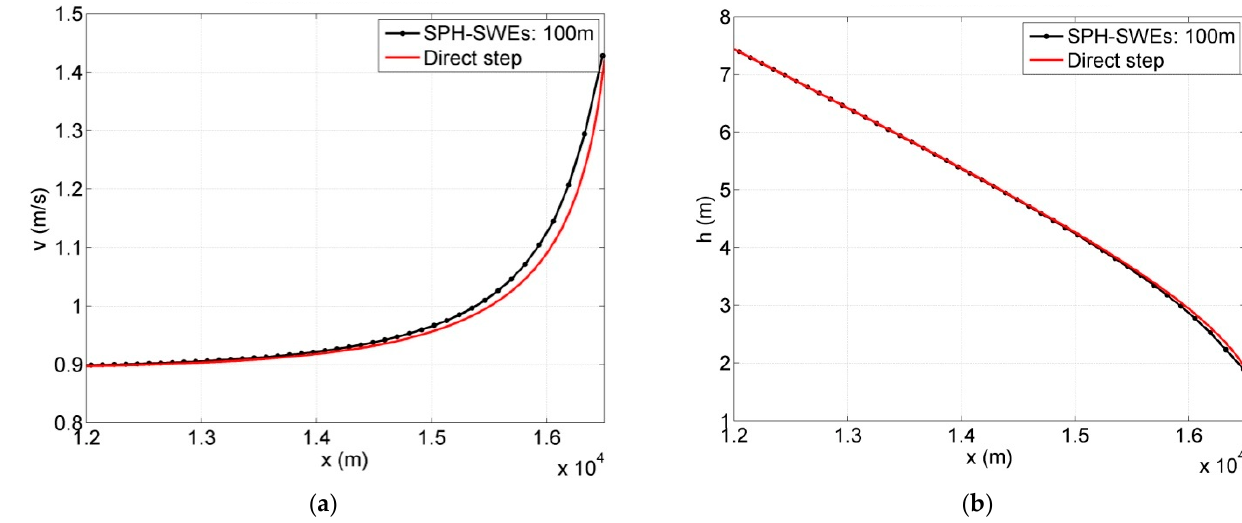
Figure 6. Results of 2D simulation for M1 curve cross-sectional view: ( a ) velocity and ( b ) water level.